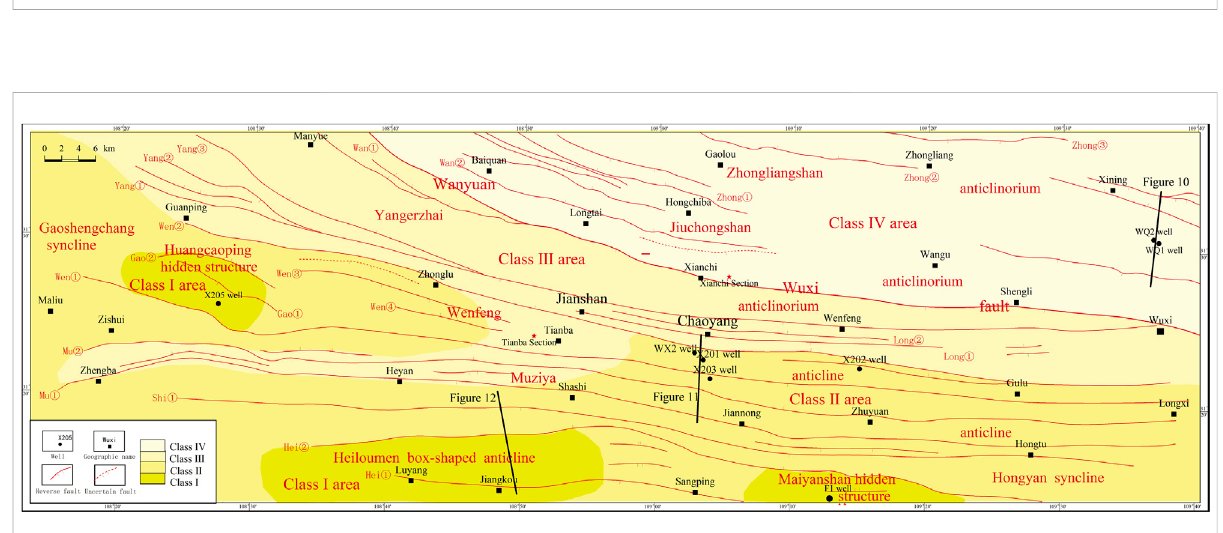
FIGURE 9 Partitioning evaluation of structural preservation conditions of shale gas enrichment and accumulation in the Wufeng − Longmaxi Formation.